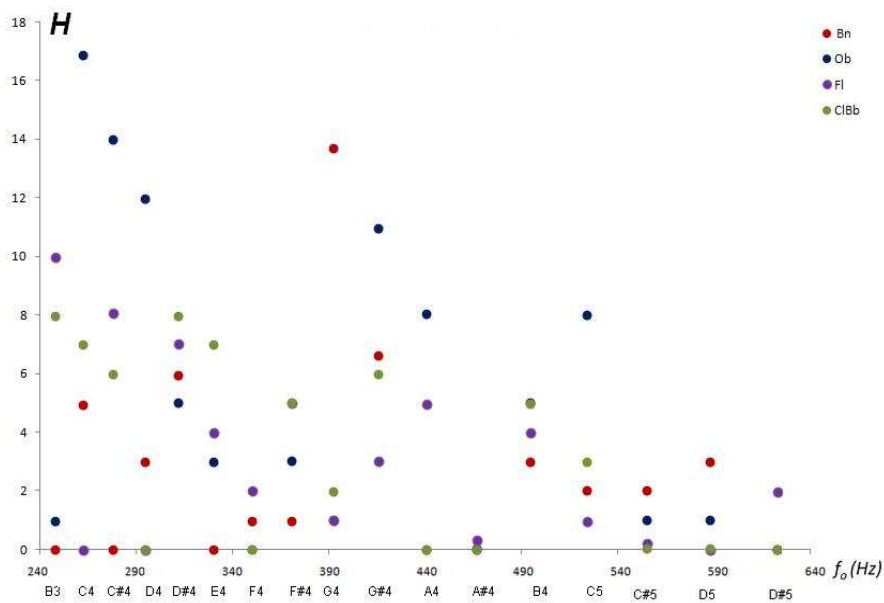
Figure 8. Variation of the Harmonicity H of aerophones in the range of sounds B3–D#5.